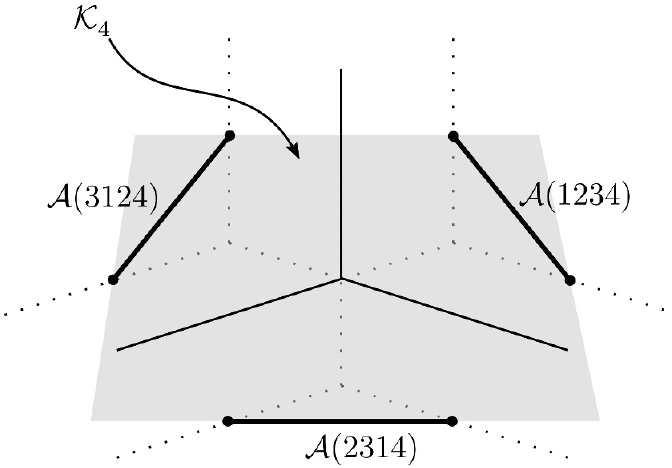
Figure 1 . The three associahedra A ( (cid:11) ) de(cid:12)ned by AHBHY’s construction at four points. The associahedra lie in a plane, kinematic space, inside R 3